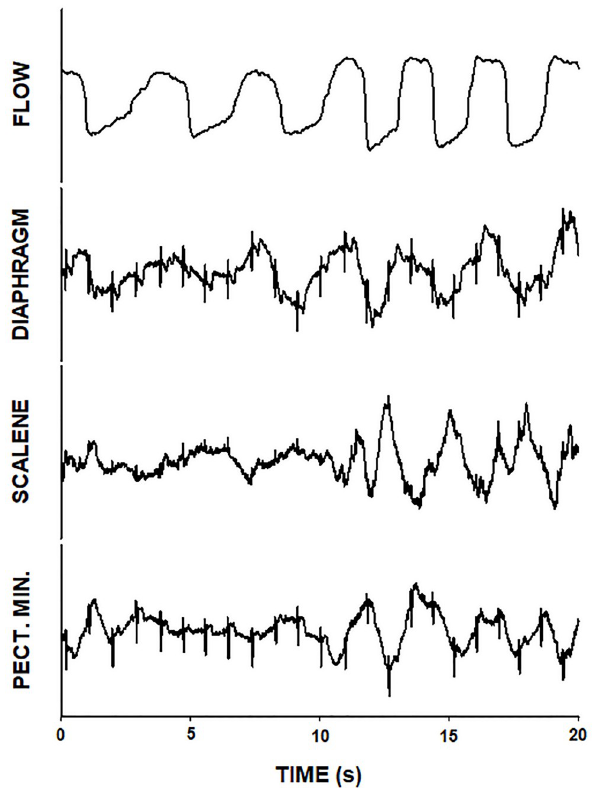
Fig 2. Example of the EMG signals from the polygraph recorder during a normalizing breathing maneuver. Breathing flow and EMG of diaphragm, scalene and pectoralis minor. All these signals are measured in Volts in arbitrary scale since they correspond to an uncalibrated flow signal sensed by nasal prongs and to the muscle activity EMG signals with an amplitude that depends on the amplifier gain. The first cycles correspond to spontaneous breathing and the last ones (starting at time 10 s approx.) correspond to maximum effort breathing. Increase in flow amplitude was associated with augmented respiratory muscles activity.